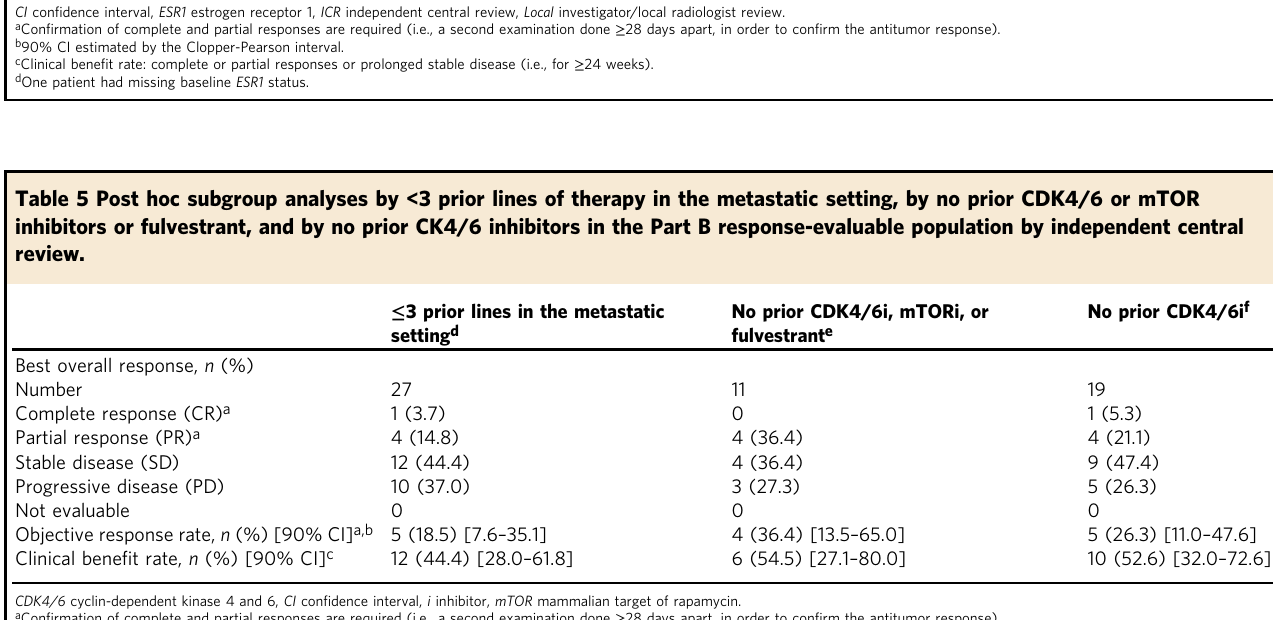
c Clinical bene fi t rate: complete or partial responses or prolonged stable disease (i.e., for ≥ 24 weeks). d Subset of Part B response-evaluable population with ≤ 3 prior lines in the metastatic setting, including ≤ 1 of either prior chemotherapy or CDK4/6 inhibitor, and no prior mTOR inhibitor. e Subset of Part B response-evaluable population with no prior fulvestrant, CDK4/6 inhibitor, or mTOR inhibitor. f Subset of Part B response-evaluable population with no prior CDK4/6 inhibitor.